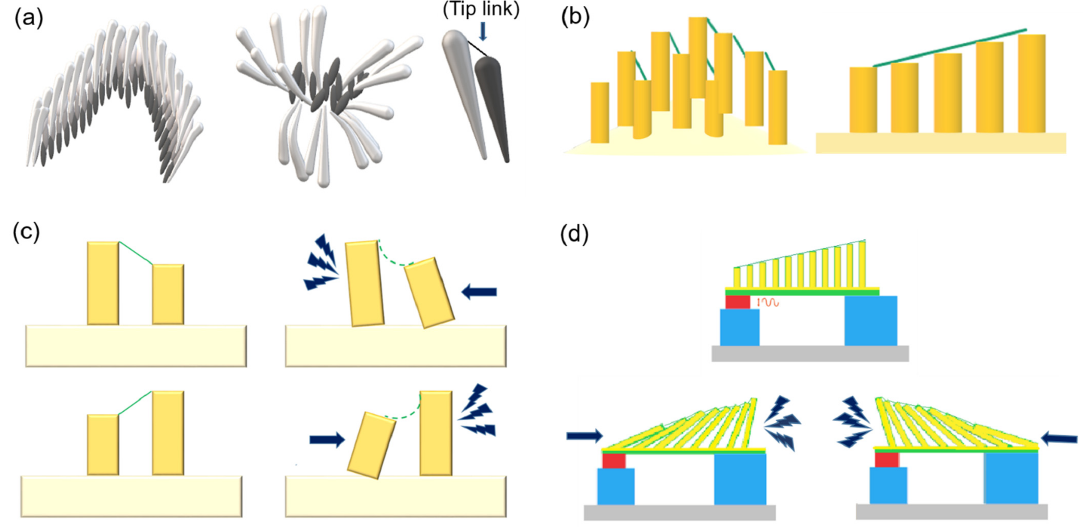
Figure 1. ( a ) Natural hair cells in the inner ear and broken hair cells; ( b ) a 3D model of artificial hair cells including polydimethylsiloxane (PDMS) pillars and electrospun PVDF tip link; ( c ) a cross-sec- tion model of neighborhood elastic pillars connected with the electrospun PVDF nanofibers mim- icking the tip links in the cochlea and ( d ) a 3D schematic of hair-cell-like sensor